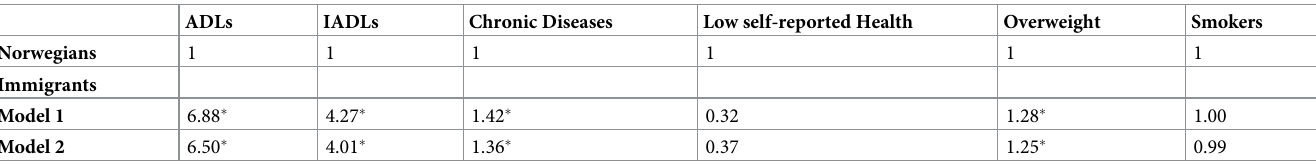
(47.5%) aligns with the presence of one or more chronic disease. A lower proportion of immi- grants (74.2%) than Norwegians (83.3%) reported to have visited a doctor the previous year. Health behaviors also varied between the two groups with a higher proportion being over- weight (65.4%) and reporting to be smokers (24.4%) among immigrants than non-immigrants. However, there is a huge variability across different immigrant groups in the prevalence of the health problems. The maximum variation is seen in being overweight (87.7–29.2 percent), fol- lowed by low self-reported health (60.1–26.7 percent) and smoking (37.4–7.9 percent). Adjusted for age, gender and education, immigrants had higher odds than Norwegians of ADL and IADL, chronic diseases and overweight (Table 2). After adjustments, there were no differences between immigrants and Norwegians in prevalence of poor self-reported health and smoking.